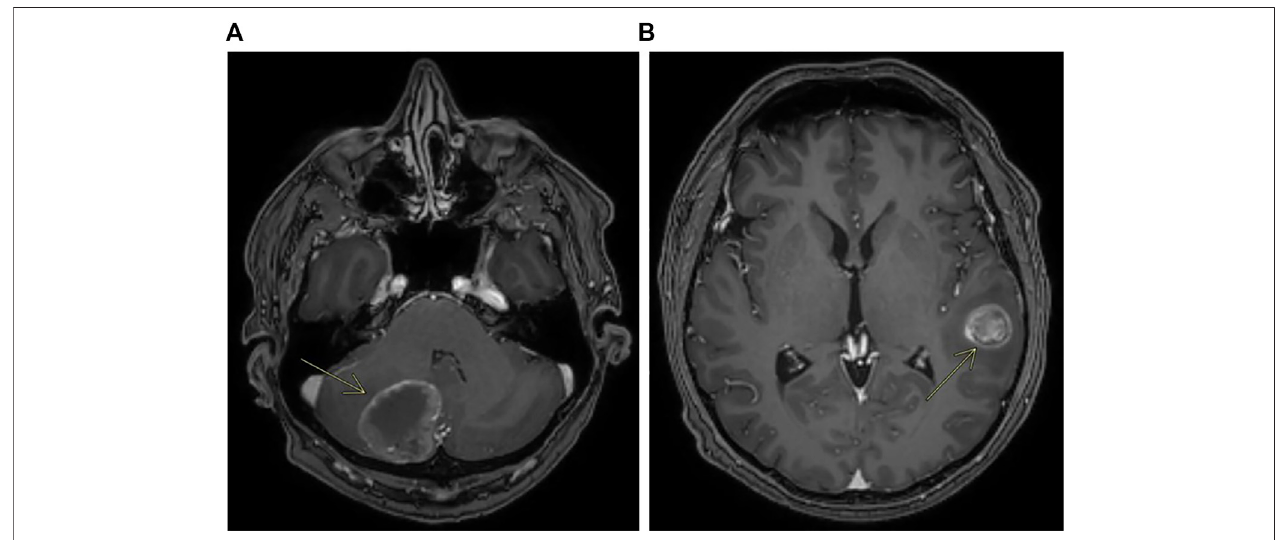
FIGURE 4 | Contrast enhanced MRI showing metastases of the cerebellum (A) and metastases of the left temporal lobe (B) .